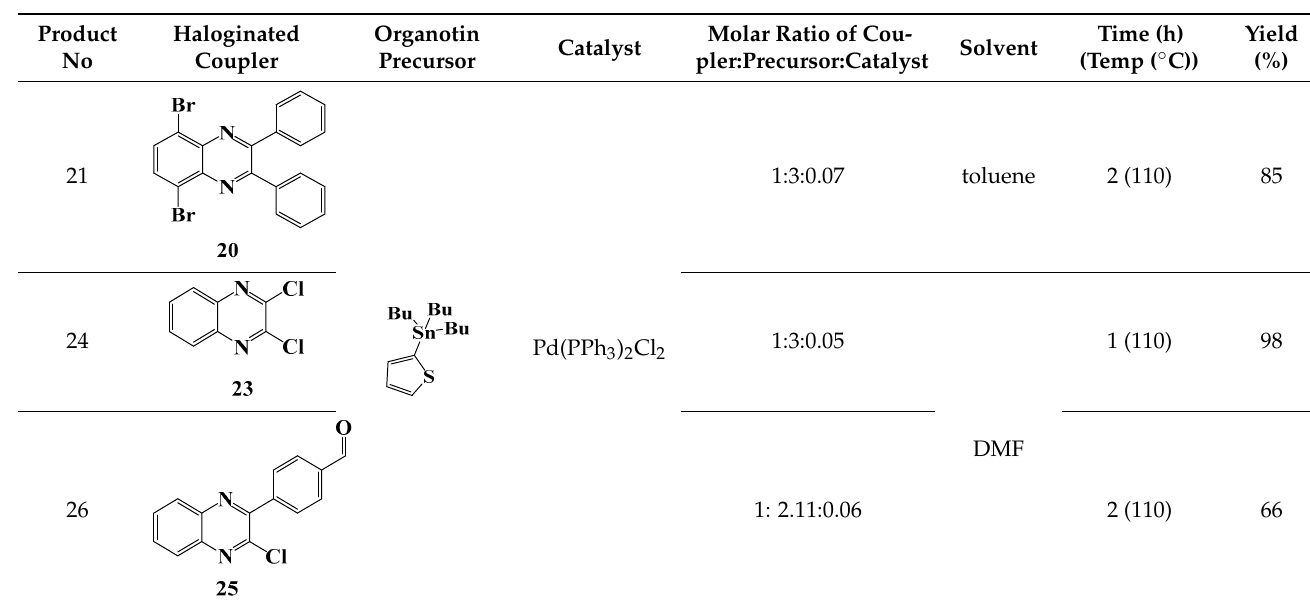
Table 3. Summary of Stille coupling reactions of halogenated QX couplers with commercial aryl- boronic acid precursors.